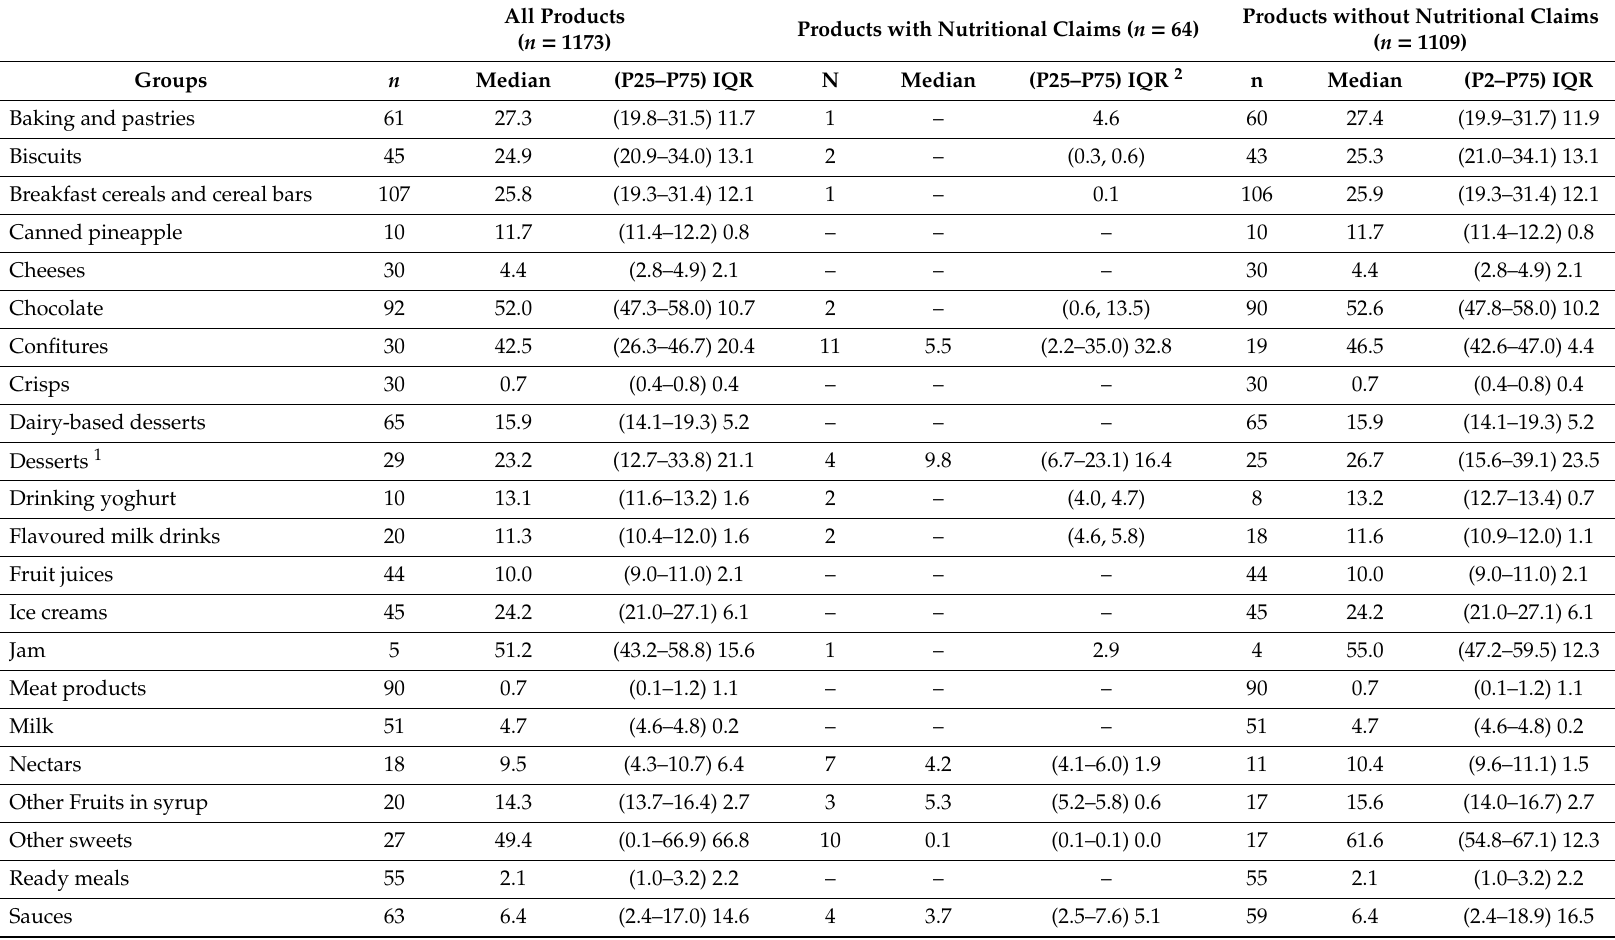
Table 2. Analytical value (AV) of the total sugar content (g / 100g of product) in the di ff erent groups of products, in the total sample, and in the two subsamples according to the presence or absence of nutritional claims related to sugar